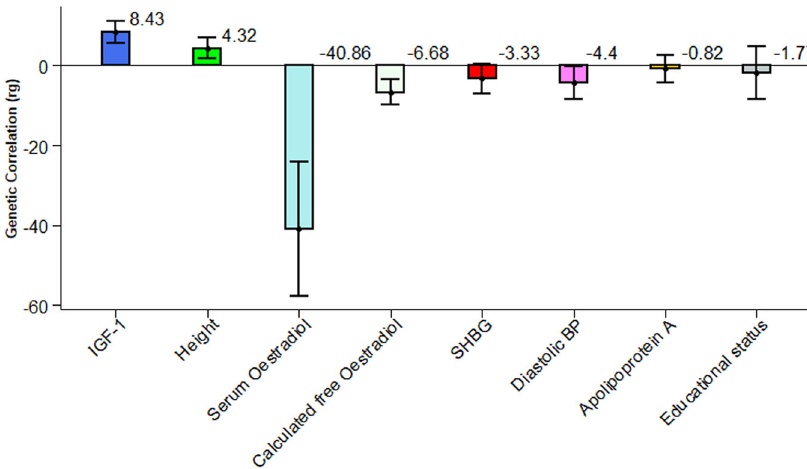
Fig. 3 Genetic correlation between all hormone-sensitive cancers [Prevalent and Incident] and non-cancer traits using bivariate GREML in the UK Biobank. The values are in percentage. SHBG Sex Hormone Binding Globulin, IGF-1 Insulin Like growth factor. The error bars are indicating the 95% CI of the estimates.